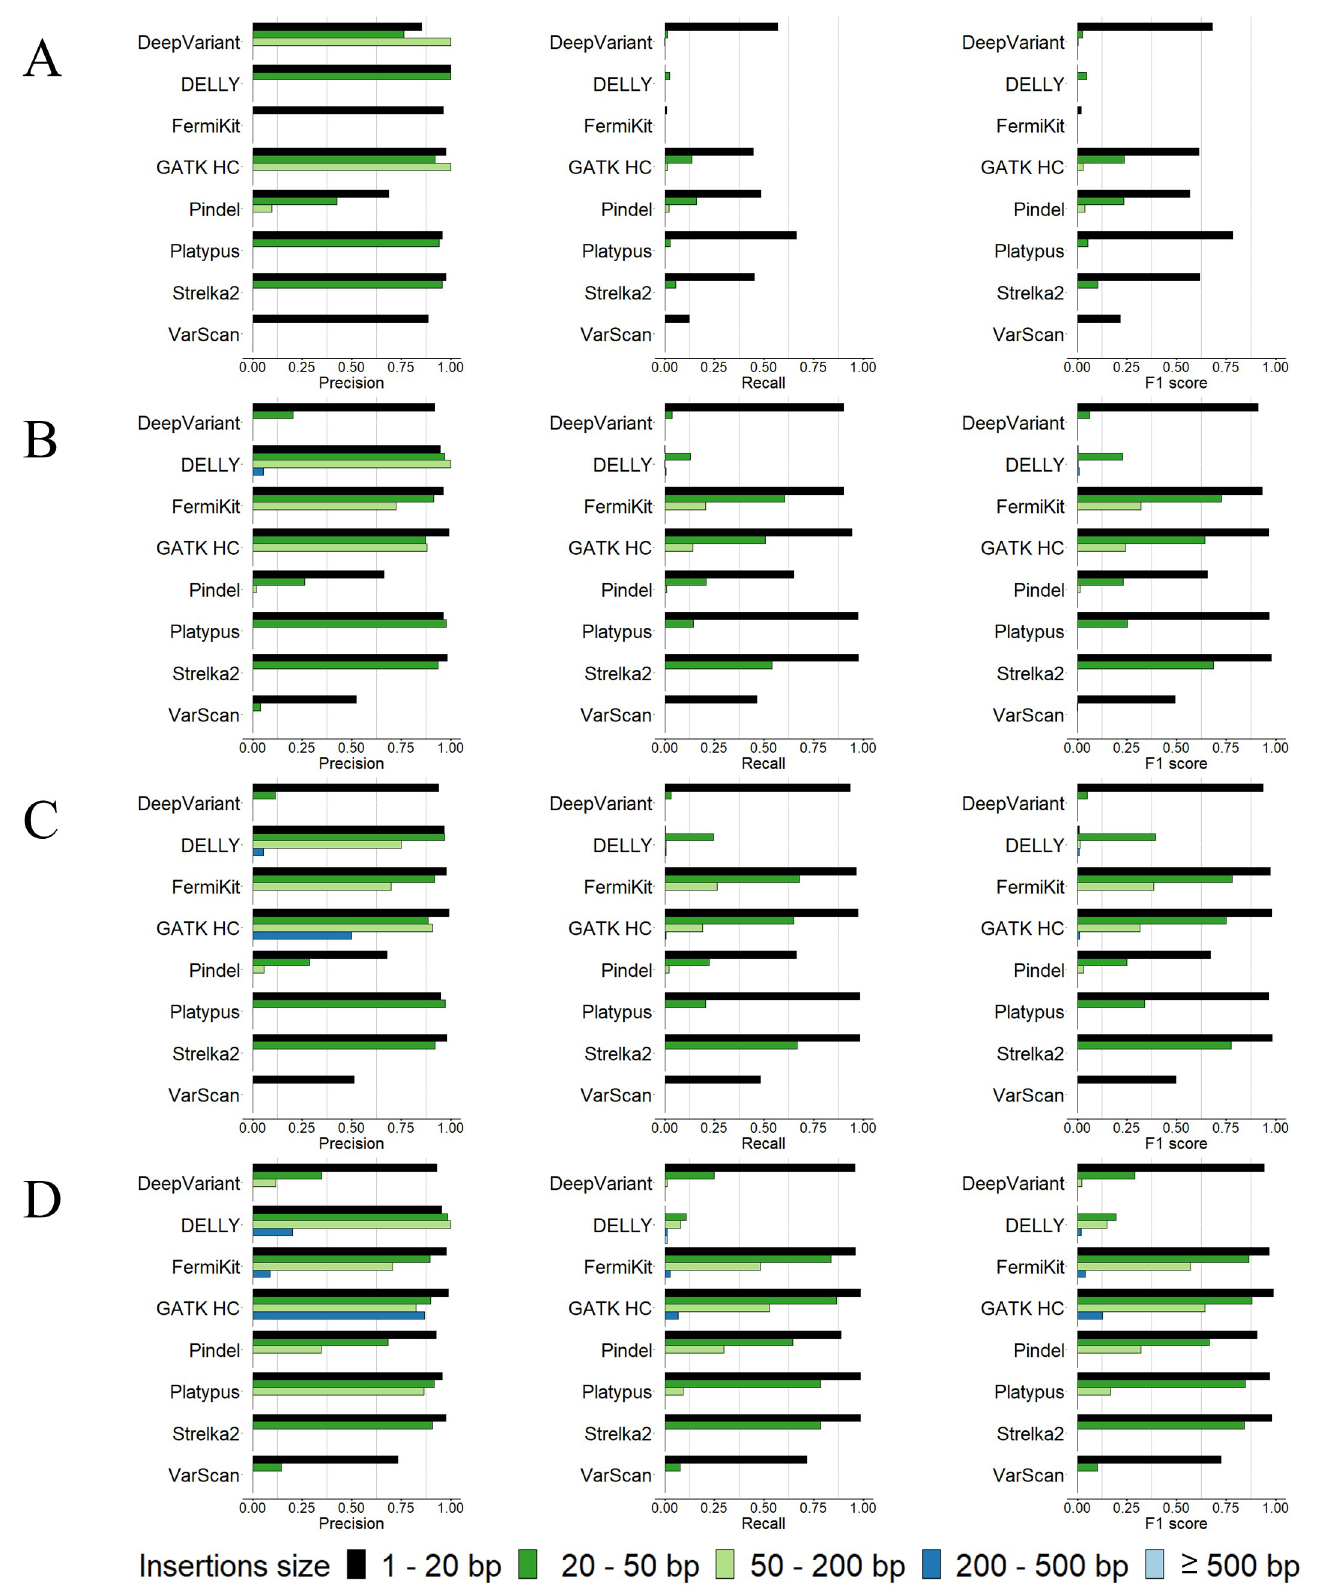
Fig 2. Precision rates, recall rates and F1 scores for tools’ insertion calling using the semi-simulated datasets. (A) 5 × coverage, 100bp read length sequencing data. (B) 30 × coverage, 100bp read length sequencing data. (C) 60 × coverage, 100bp read length sequencing data. (D) 30 × coverage, 250bp read length sequencing data. https://doi.org/10.1371/journal.pcbi.1009269.g002 PLOS Computational Biology | https://doi.org/10.1371/journal.pcbi.1009269 February17, 2022 11 /